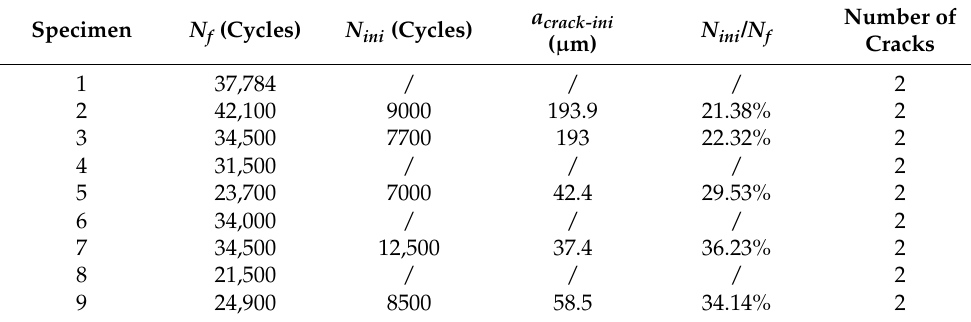
Table 3. Biaxial fatigue test results of cruciform specimens.